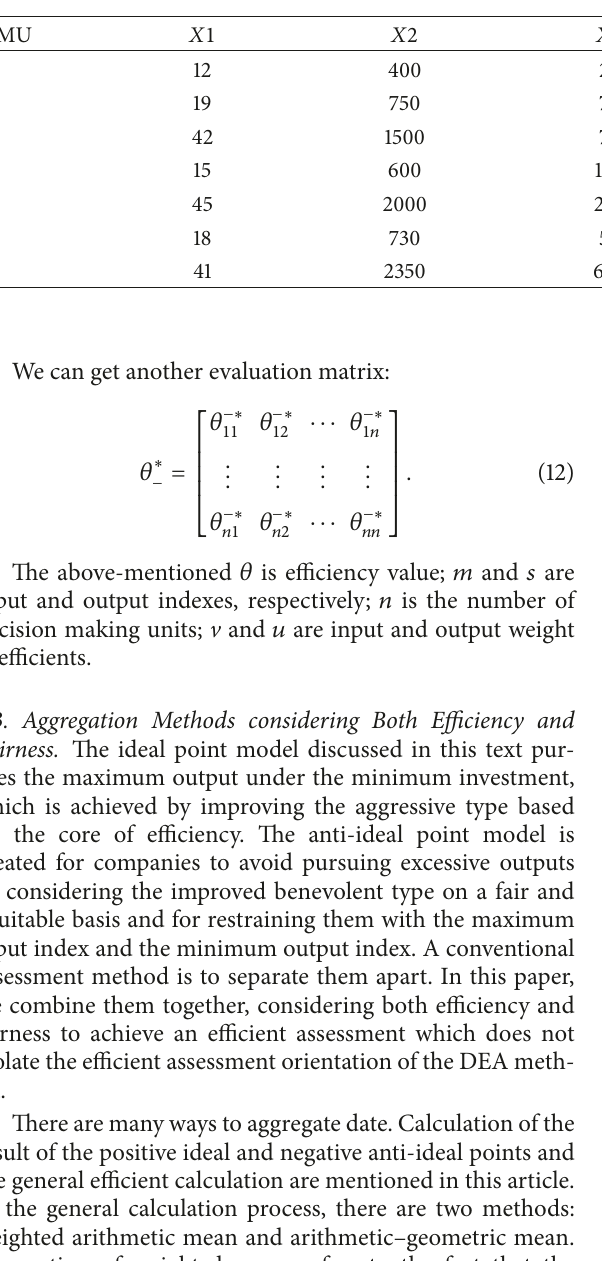
Table 1: Data for seven DMUs with three inputs and three